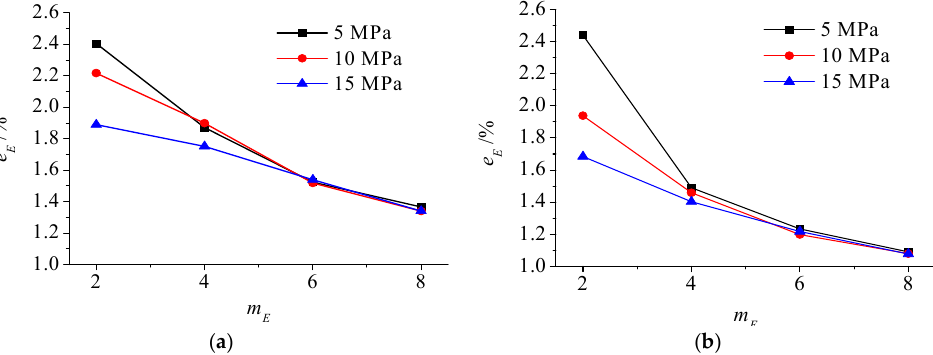
Figure 4. ( a ) The mean value and ( b ) standard deviation of relative error of Young’s modulus field of Scheme I.